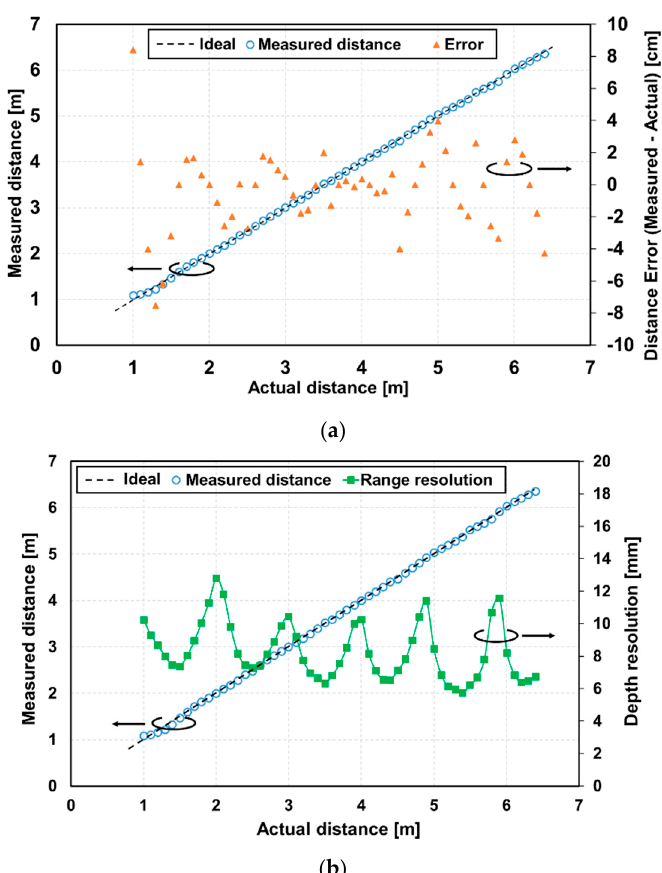
Figure 11. Measured distance versus real distance with an SP-TOF-specific timing: ( a ) non-linearity error and measured distance, and ( b ) depth resolution and measured distance.